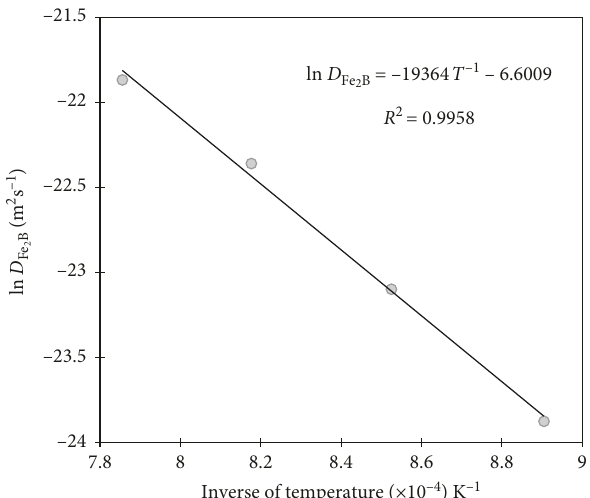
) from the second approach in the Fe 2 B layer (non-steady-state Fe 2 B